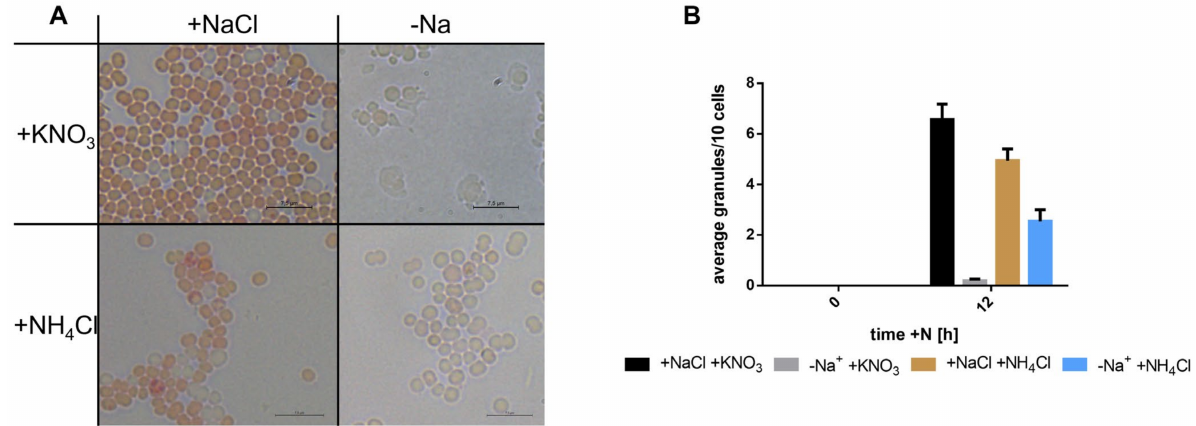
Figure 4. Cyanophycin production in the presence and absence of sodium. ( A ) shows pictures of cells after 12 h of resuscitation with nitrate or ammonium, in the presence or absence of sodium. Cells were stained with the Sakaguchi staining method. Scale bar depicts 7.5 µ m in each picture. ( B ) depicts the amount of cyanophycin granules per cell during resuscitation, counted after Sakaguchi staining. Samples were taken before start of resuscitation and 12 h after start. At least 200 cells were counted per sample per time point.